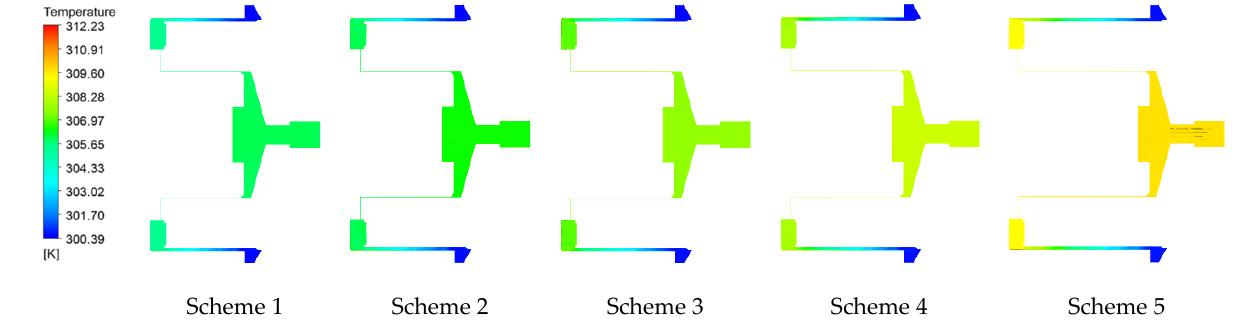
Figure 17. Comparison of the temperature distribution of different schemes.